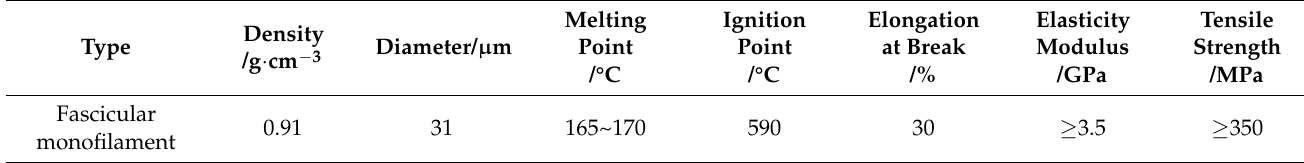
Figure 2. Curve representing the distribution of filler’s grain sizes. Table 1. Physicomechanical characteristics of polypropylene fiber [37,38].